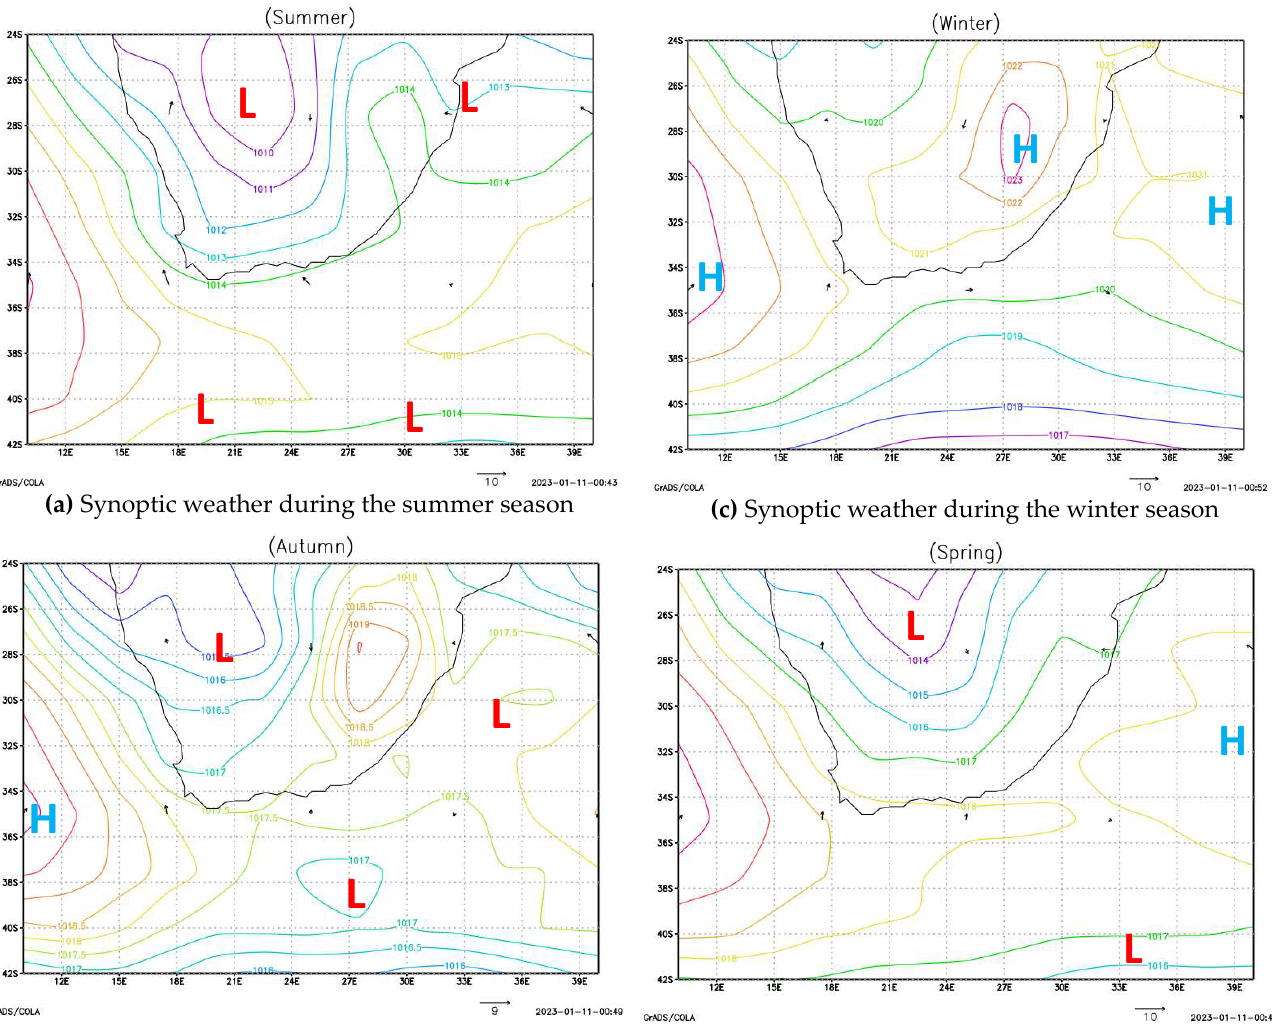
Figure 6. Seasonal atmospheric synoptic weather circulation system in South Africa. H represent High pressure, and L represent Low pressure.